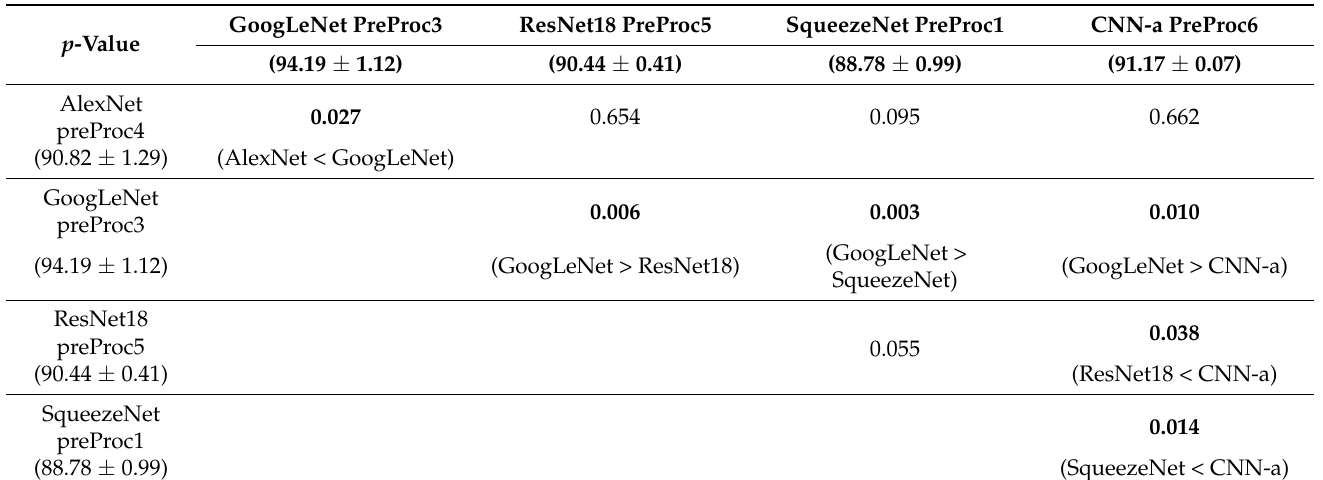
Table 4. Levels of significance ( p -values) obtained from the statistical analysis of the difference between the best mean AUCs found.